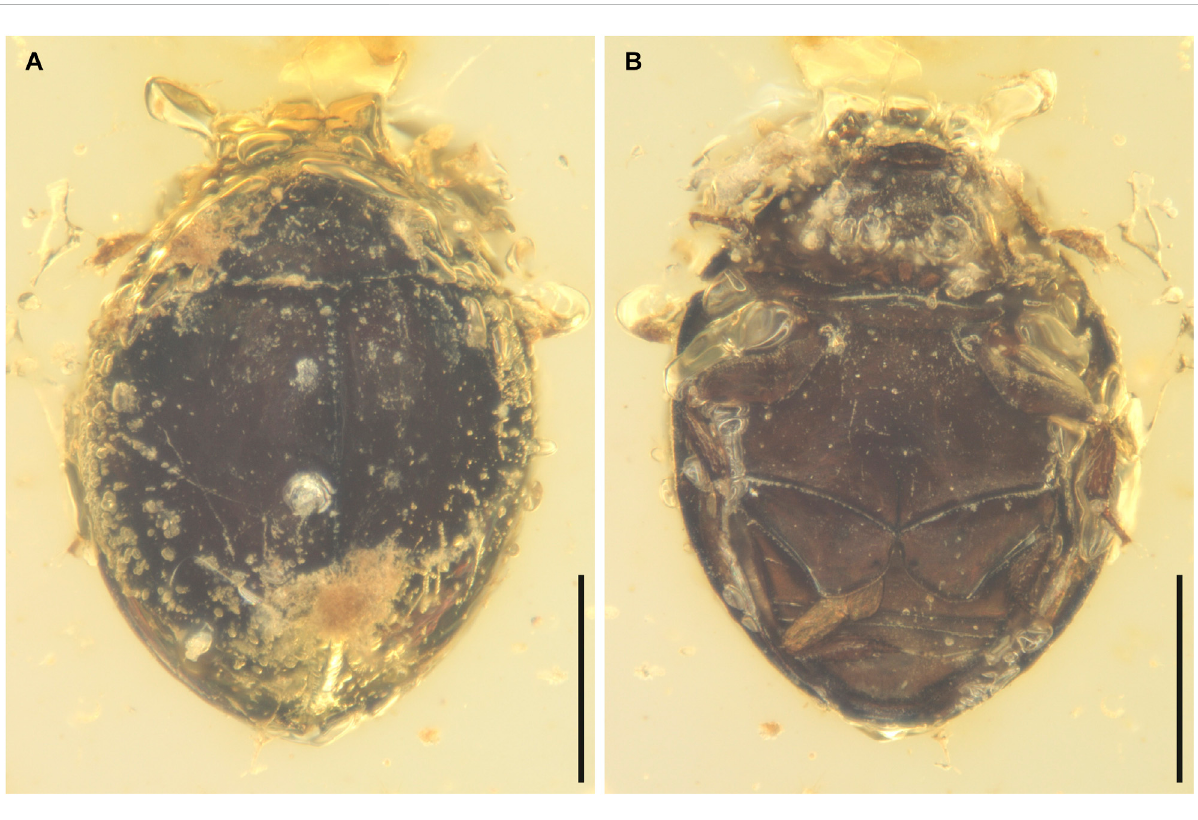
FIGURE 1 General habitus of Sphaeriusmartini Liand Cai sp.nov., holotype, NIGP178177, underincident light. (A) Dorsalview. (B) Ventralview.Scale bars: 200 μ